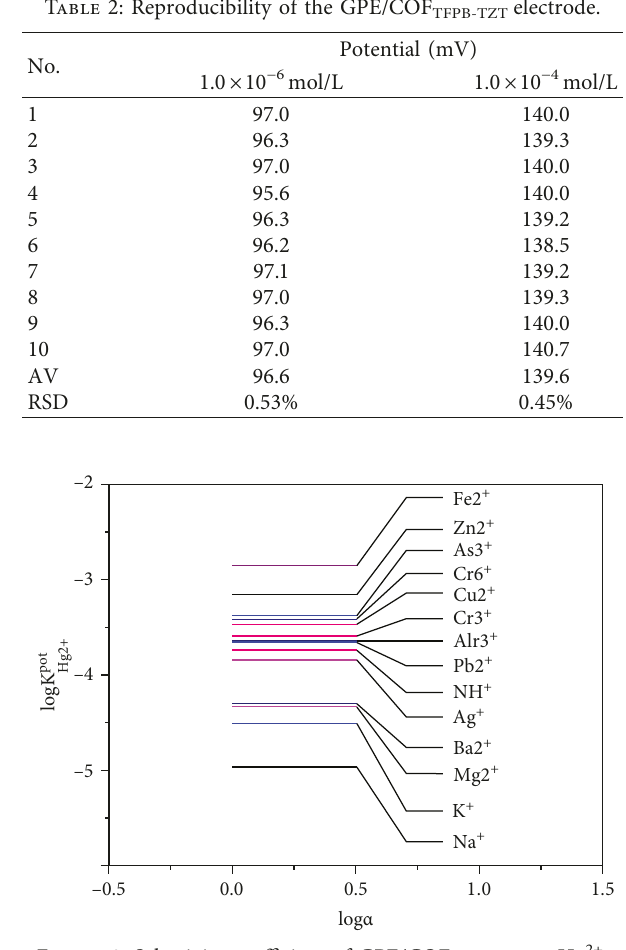
Figure 8: Selectivity coefficient of GPE/COF